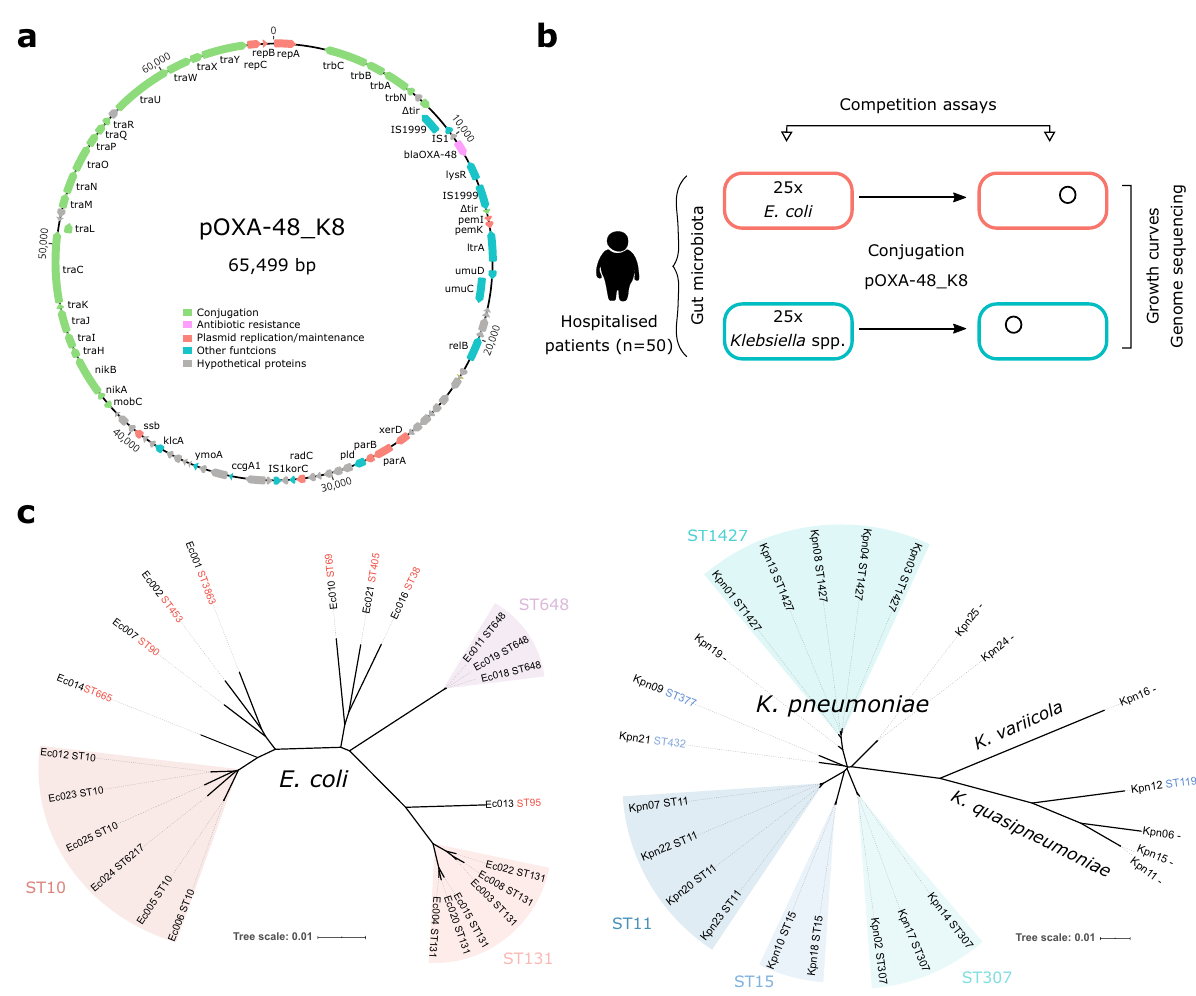
Fig. 1 Experimental model system. Representation of pOXA-48_K8 plasmid and the enterobacteria strains used in this study. a pOXA-48_K8 (accession number MT441554). Reading frames are shown as arrows, indicating the direction of transcription. Colours indicate gene function classi fi cation (see legend). The bla OXA-48 gene is shown in pink. b Schematic representation of the experimental design used in this study. c Unrooted phylogeny of whole- genome assemblies from E. coli clones (left) and Klebsiella spp. clones (right). Branch length gives the inter-assembly mash distance (a measure of k-mer similarity). The grouping of multilocus sequence types (ST) is also indicated ( E. coli ST6217 belongs to the ST10 group). Note that the sequencing results revealed that a subset of isolates initially identi fi ed as K. pneumoniae were in fact Klebsiella quasipneumoniae ( n = 4) and Klebsiella variicola ( n = P = 0.54. Klebsiella spp., AUC, V = 54, P = 0.003; OD max , V = 44,